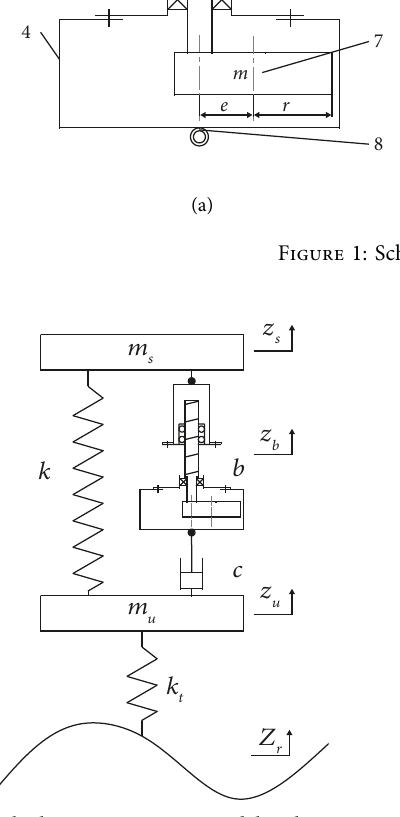
Figure 2: The vehicle ISD suspension model with series-connected eccentric inerters.